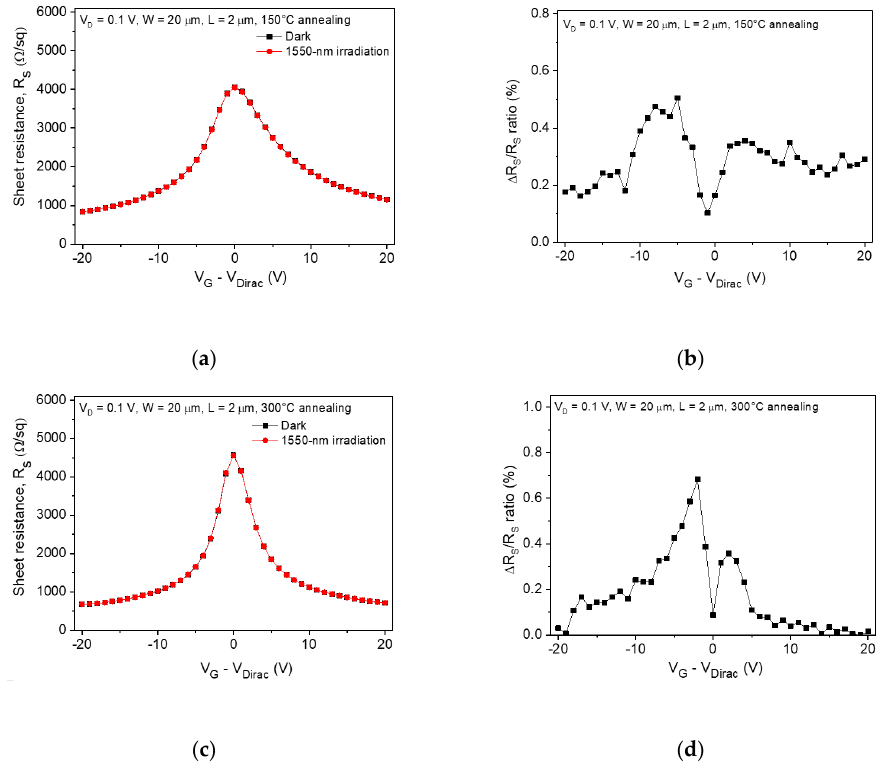
Figure 3. Sheet resistance as a function of gate bias extracted from the total device resistance measured after ( a ) 150 °C and ( c ) 300 °C annealing under dark and illuminated conditions. ( b ), ( d ) Change ratio in the sheet resistance as a function of gate bias calculated from ( a ) and ( c ),